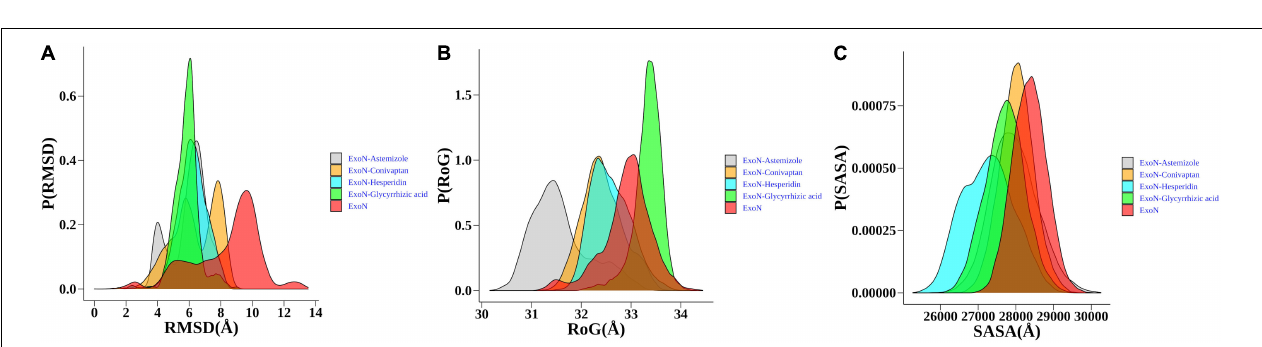
FIGURE 4 | Putative binding pockets of docked compounds. Interaction of ExoN residues (gray) with docked conformer of hesperidin (green sticks) (A) and glycyrrhizic acid (purple sticks) (B) . H-bonded residues are depicted as sticks. Yellow dotted lines represent hydrogen bond, and the distance is in angstroms (Å). Residues in hydrophobic contact are depicted as surface representation.